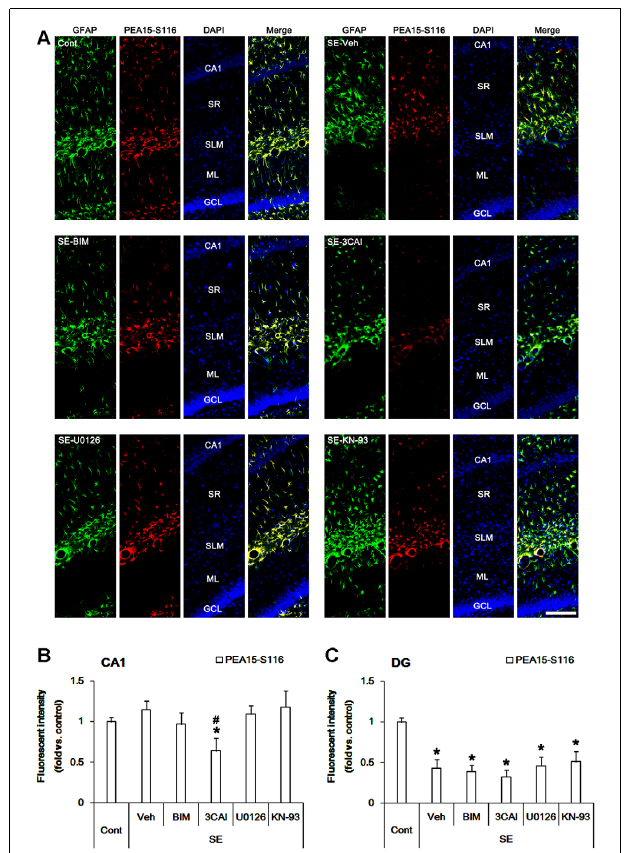
FIGURE 3 | Changes in PEA15-S116 phosphorylation in the hippocampus following SE. SE elevates PEA15-S116 phosphorylation in CA1 astrocytes, which is attenuated by 3CAI, but not BIM, U0126 and KN-93. SE decreases PEA15-S116 phosphorylation in dentate astrocytes, which is unaffected by BIM, 3CAI, U0126 and KN-93. (A) Representative immunofluorescent images for GFAP and PEA15-S116 phosphorylation following SE. Bar = 100 µ m. Abbreviations: CA1, CA1 pyramidal cell layer; SR, stratum radiatum; SLM, stratum lacunosum-moleculare; ML, molecular layer; GCL, dentate granule cell layer. (B,C) Quantification of the fluorescent intensities of PEA15-S116 phosphorylation in CA1 astrocytes (B) and dentate astrocytes (C) . Error bars indicate SEM ( ∗ , # p < 0.05 vs. control- and vehicle-treated animals, respectively; n = 7, respectively).